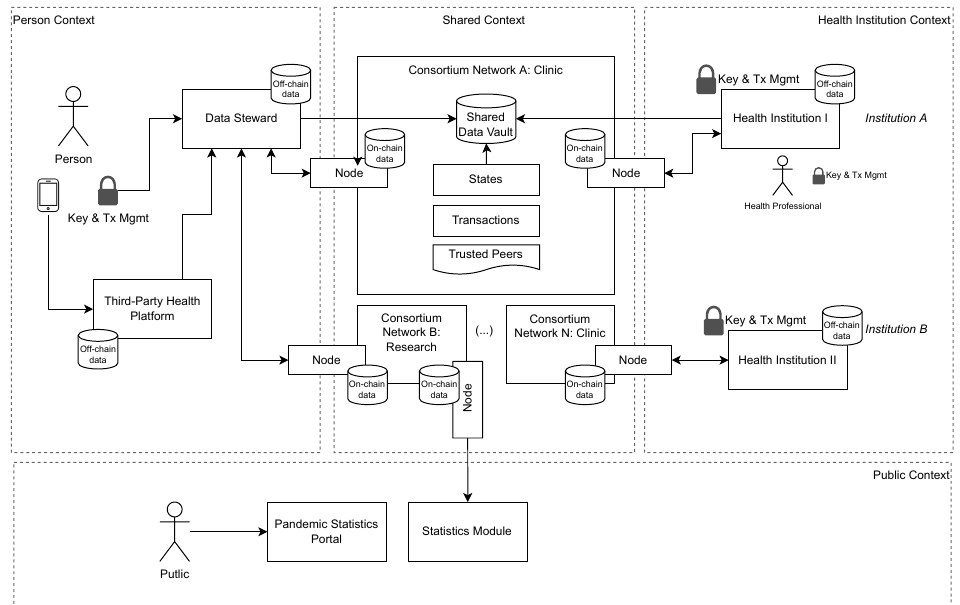
Figure 2. Proposed solution organized in multiple contexts: Personal context for data collected outside the medical environment, health institution context for data collected in a medical environment, the public context for statistical calculation and visualization of FHE, and shared context for the exchange of data among all other